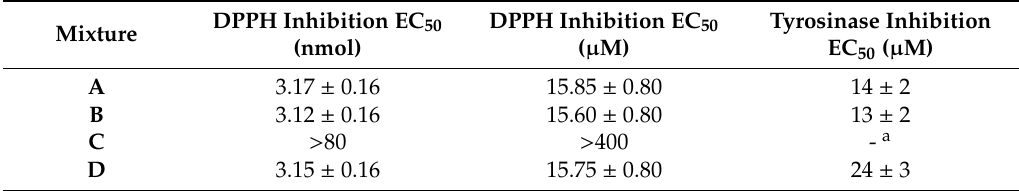
Table 3. EC 50 of mixtures for DPPH and tyrosinase inhibition.